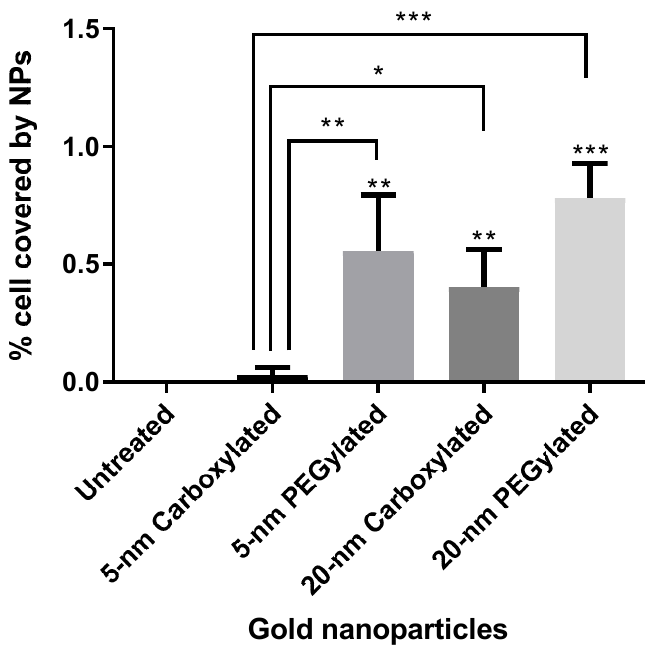
Figure 5. Percentage of BEAS-2B cells covered by gold nanoparticles (NPs) after a 48-h treatment with 5 µg/mL carboxylated and PEGylated gold NPs. In total, 15 cells were analyzed per treatment. The p -values are in comparison with untreated cultures or 5-nm carboxylated gold NPs (Kruskal–Wallis test with Dunn post hoc test): * p < 0.05; ** p < 0.01; *** p < 0.001.